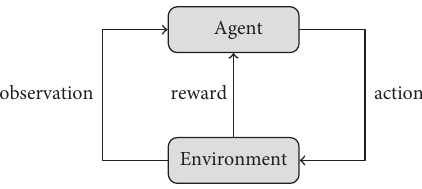
Figure 2: Reinforcement learning